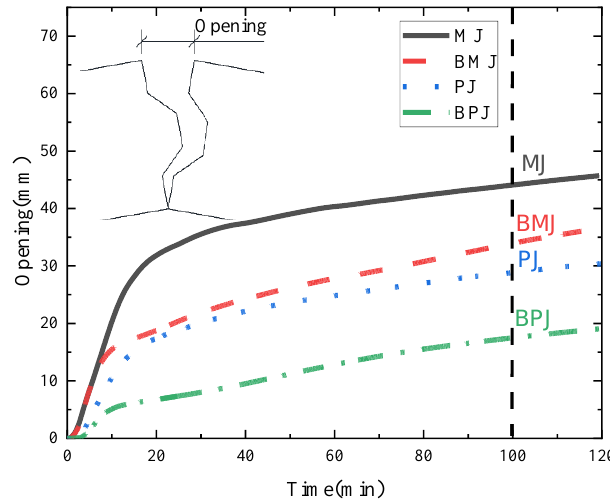
Figure 14. The opening gap fire time of the four joints.